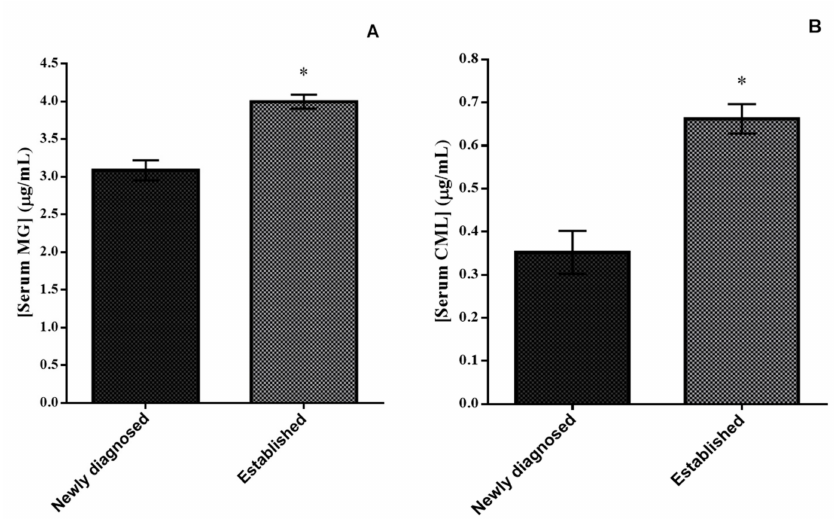
Figure 1. Serum levels of methylglyoxal ( µ g / mL) ( A ) and carboxy-methyl-lysine ( µ g / mL) ( B ) in T2DM patients studied. One-way ANCOVA results (adjusted mean ± SEM) controlling for age, sex and BMI. * p < 0.001 indicates significant di ff erences.